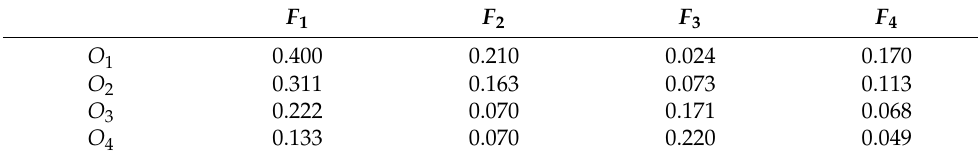
Table 3. Weighted normalized values.